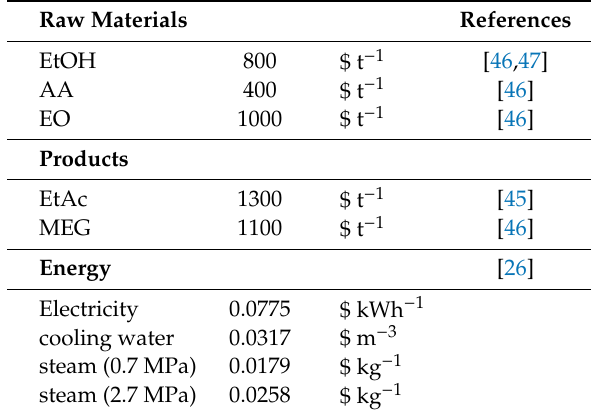
Table 10. Prices of raw materials, products, and energy used in process economic evaluation.